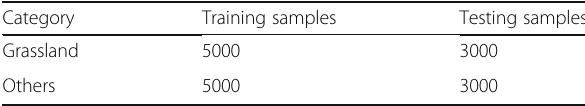
Table 2 Training samples and testing samples